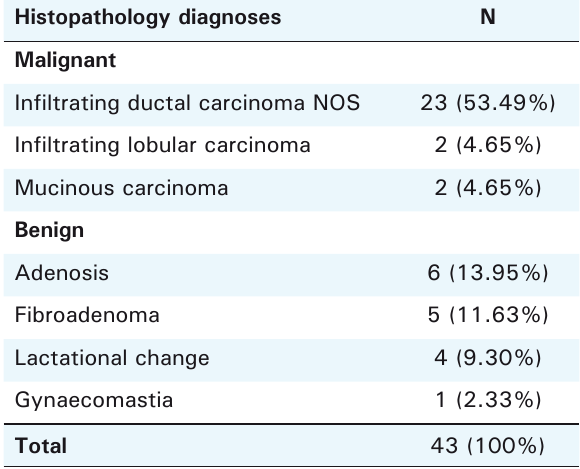
table 3. Subsequent histopathological diagnoses of suspicious cases in